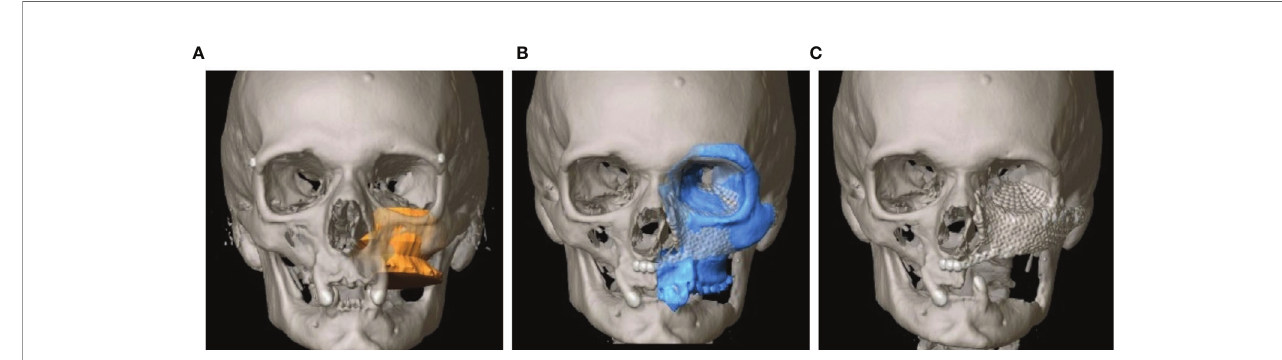
FIGURE 4 | Virtual reconstruction planning using the principle of mirroring. (A) Segmented tumor of the left maxillary sinus with in fi ltration into the left fl oor of the orbit (yellow). (B) Template of the healthy right midface mirrored to the left (blue). (C) Postoperative CT shows the reconstruction of the orbit and the midface using two PSIs.